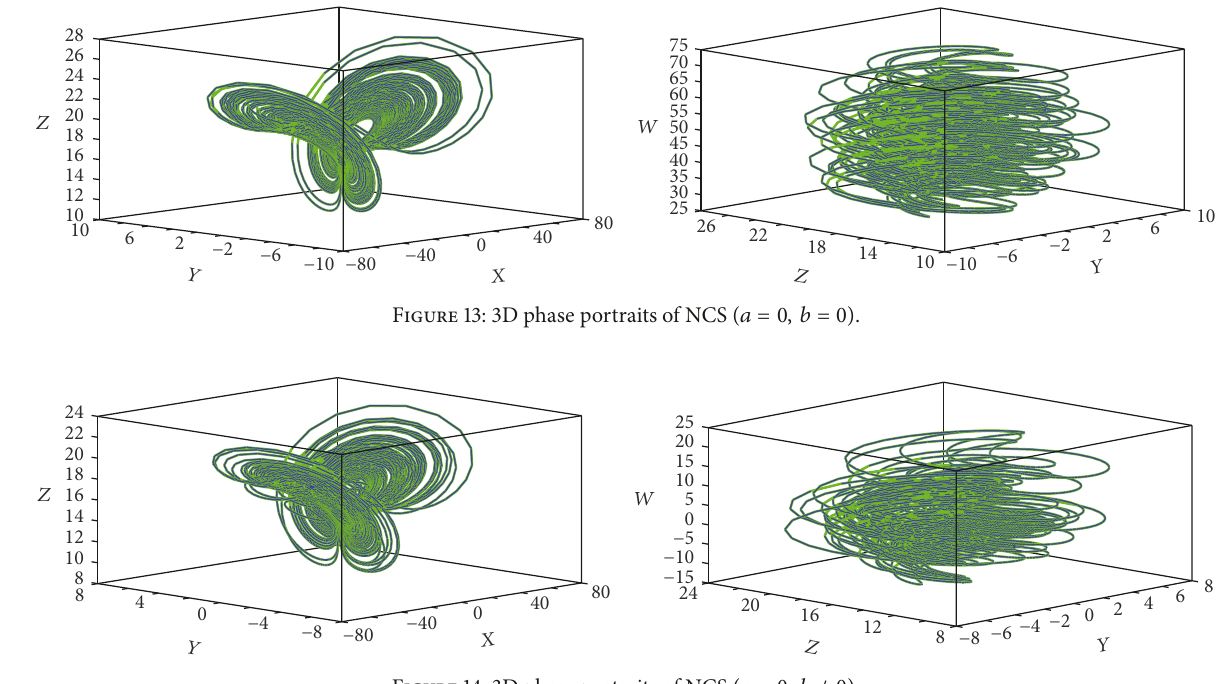
Figure 14: 3D phase portraits of NCS ( 𝑎 = 0, 𝑏 ̸= 0 ).